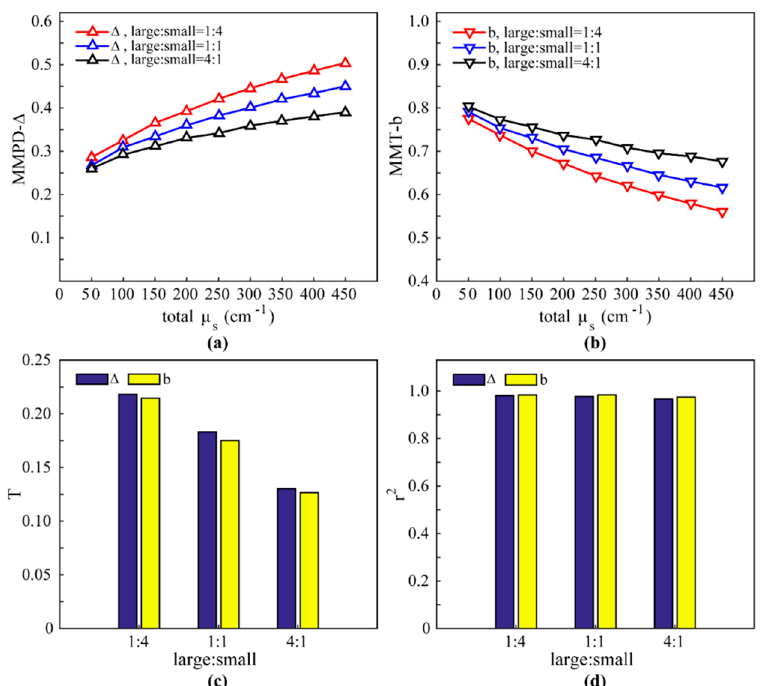
Figure 4. Monte Carlo (MC) simulation results of bi-component sphere model in the backward direction: ( a ) MMPD parameter Δ . ( b ) MMT parameter b . ( c ) T of Δ and b ; the codomains of both parameters are [0,1]. ( d ) The r 2 of Δ and b .